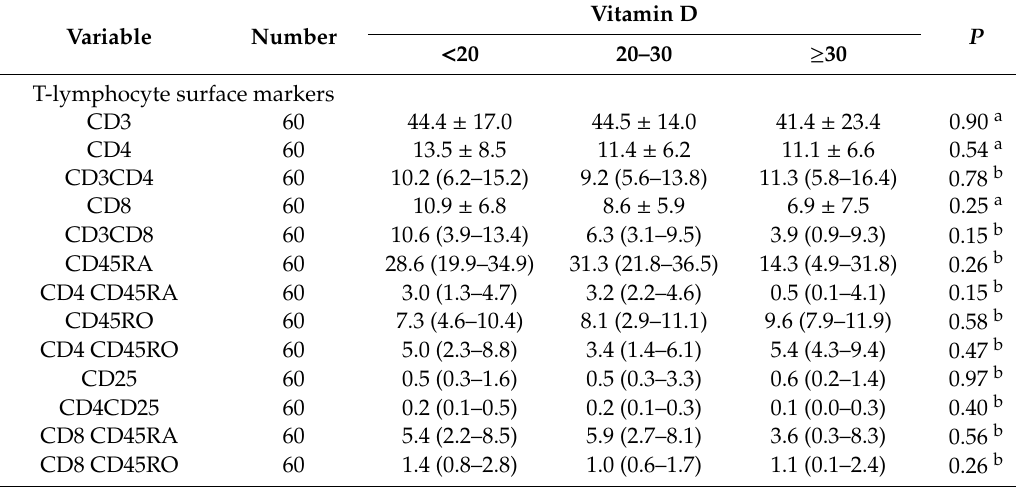
Table 3. T-lymphocyte and B-lymphocyte surface